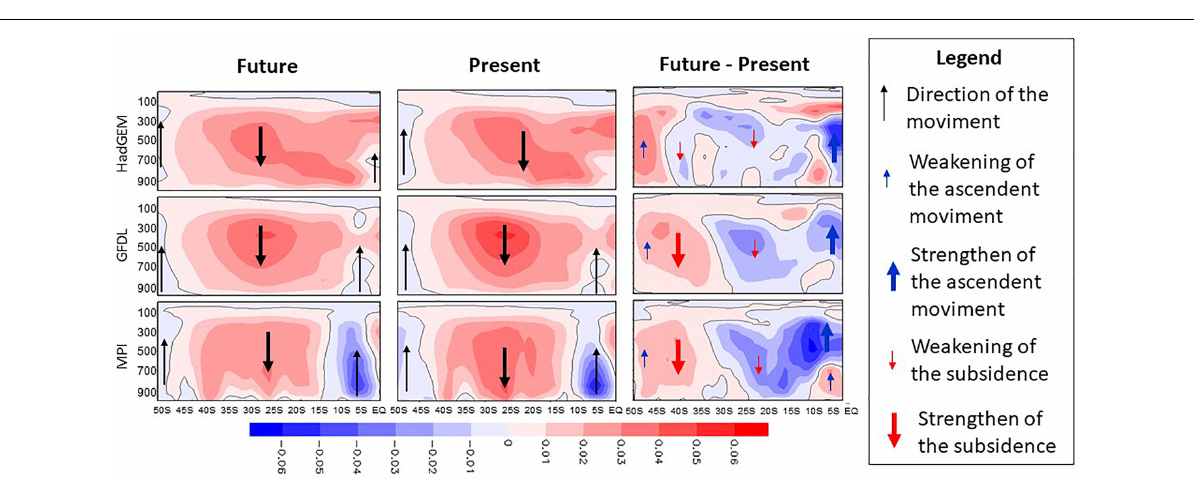
FIGURE 9 | Latitude-height cross sections of the vertical velocity (omega; Pa s − 1 ) in summer for the future, present and the difference future minus present. The black line indicates the zero